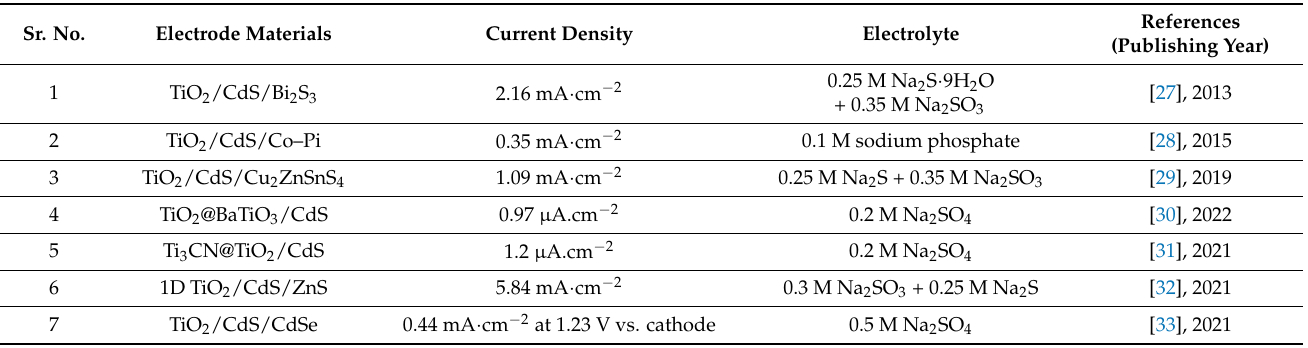
Table 1. Comparison of fabricated photoanode TiO 2 /CdS/BiSbS 3 with previous